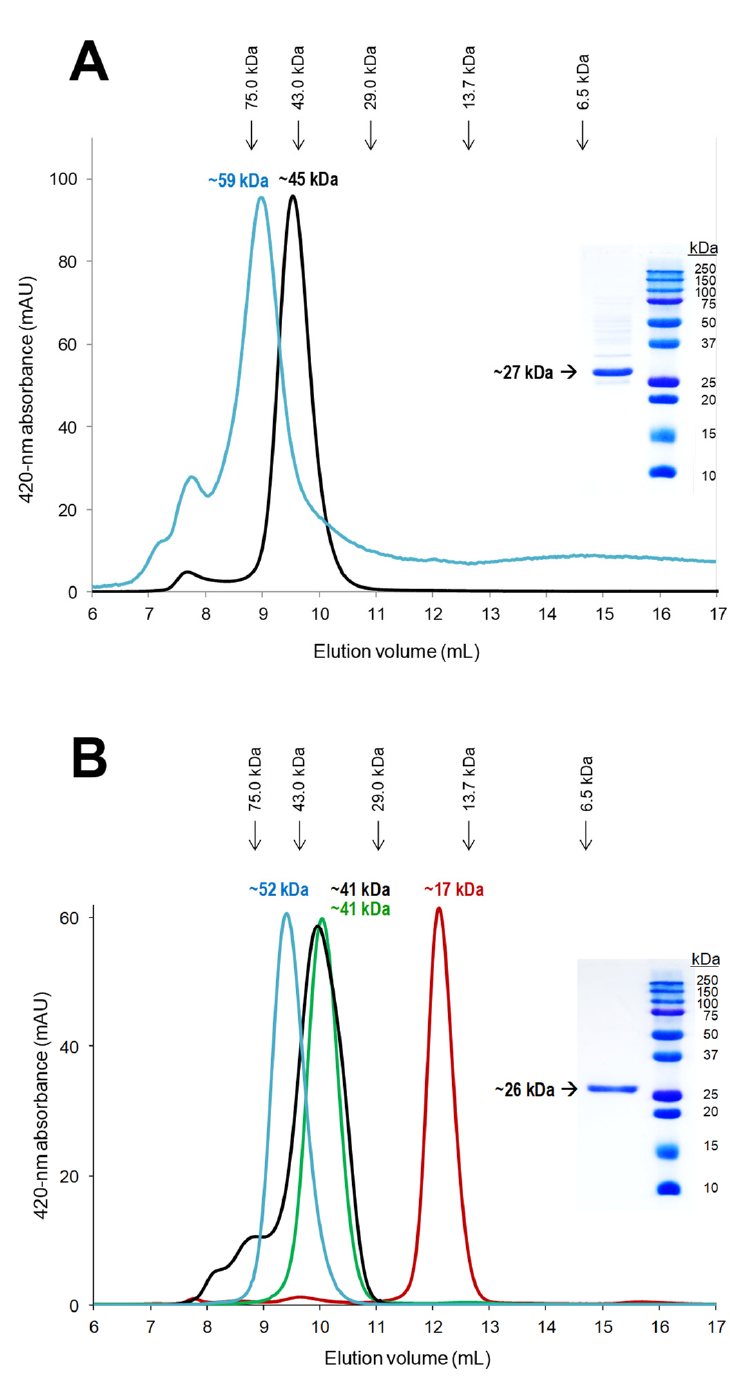
Figure 4. SEC profiles and SDS-PAGE images (insets) of recombinant UPOs and variants (the positions of standards are indicated). ( A ) r Mro UPO (black) and its C227A variant (blue). ( B ) r Cvi UPO (black) and its C235A (blue), K228stop (green), and P201stop (red) variants. SEC was performed with a Superdex 75 column and isocratic elution with 10 mM Tris (pH 7.4) containing 0.15 M NaCl (given the low production of the C227A variant, its absorbance in A is multiplied by a factor of 15). SDS-PAGE was performed with 0.1% SDS containing 1% mercaptoethanol, and same protein amount (~1.7 µ g) was loaded in each case.